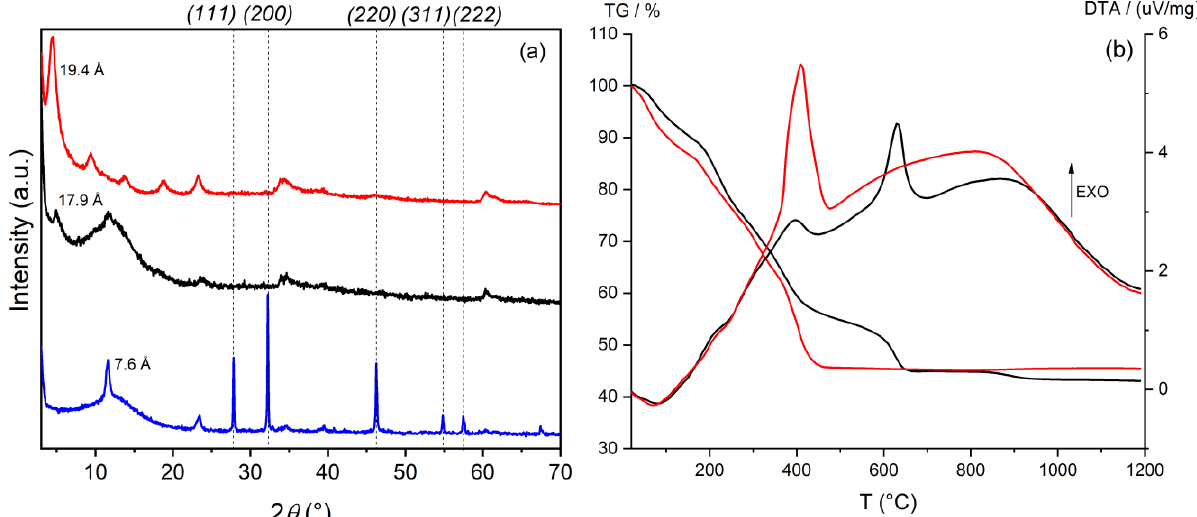
Figure 3. ( a ) XRD pattern of Ag/ZnAl-Ac (blue line), Ag/ZnAl-CFZ (black line), and Ag/ZnAl-NAL (red line). The crystalline phases reported belong to the cubic phase of AgCl NPs (PDF number: 85- 1355). ( b ) TGA and DTA of Ag/ZnAl-CFZ (black line), Ag/ZnAl-NAL (red line), operative conditions: heating rate: 10 °C/min, air.